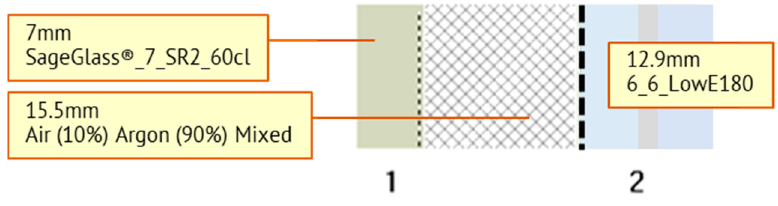
Figure 1. EC glazing system configuration modeled in LBNL WINDOW (v. 7.6).